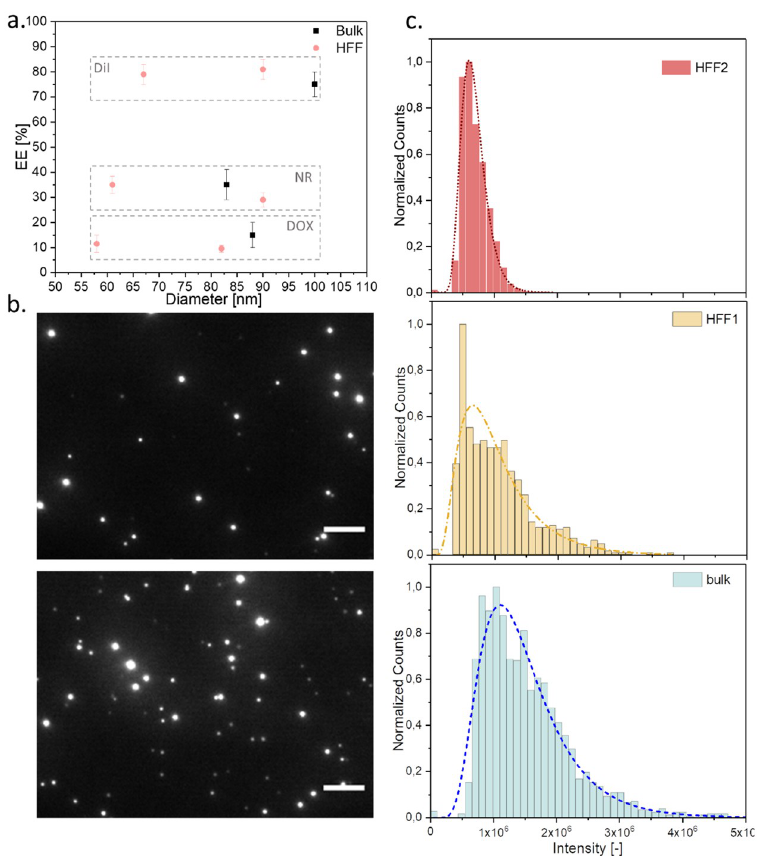
Fig 3. Encapsulation of fluorescent compounds. a. EE for DiI, NR and DOX loaded NPs, formulated with HFF and bulk nanoprecipitation, b. TIRF images of DiI loaded NPs formulated with HFF and bulk method (top: HFF1 = 95 nm, bottom: bulk = 89 nm), scale bar 5 μ m. c. Analysis of emitted fluorescence intensity per particle for DiI loaded NPs, formulated with HFF and bulk methods, size by DLS: HFF1 = 95 nm, HFF2 = 71 nm, Bulk = 89